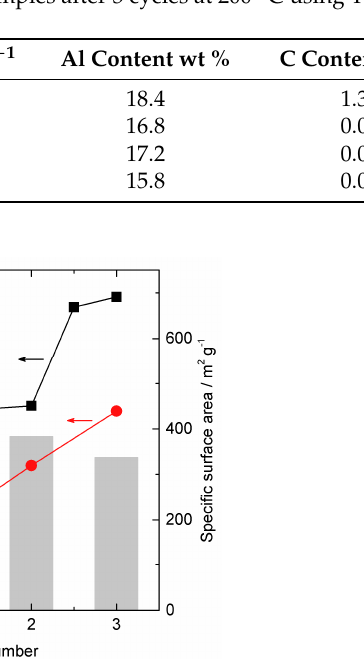
Table 2. Scale-up samples of SiO 2 powder coated samples after 3 cycles at 200 ◦ C using TMA and H 2 O.